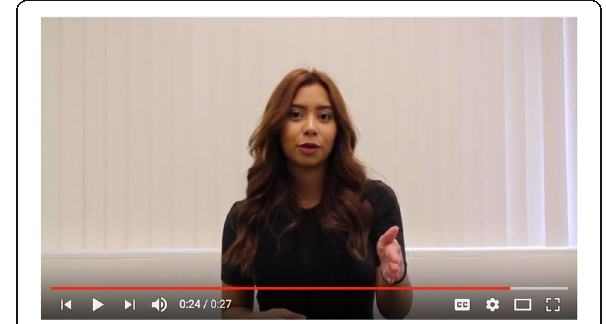
Fig. 2 Gesture used in the variability condition. Both hands were used to represent the mean and variability of each group. In this picture the experimenter represents test performance of the group that ate chocolate. She shifts both hands to the left to represent the no chocolate